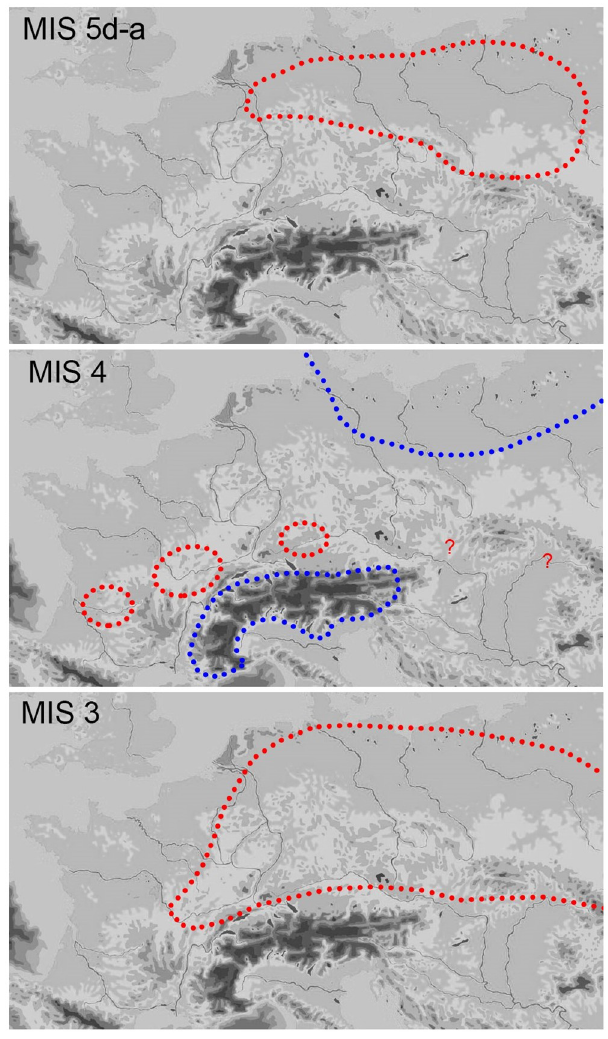
Fig 24. Site distribution of Keilmessergruppen techno-complex in the early Weichselian, between MIS 5 and MIS 3. The red zones were possibly populated, the blue zones were occupied by permanent